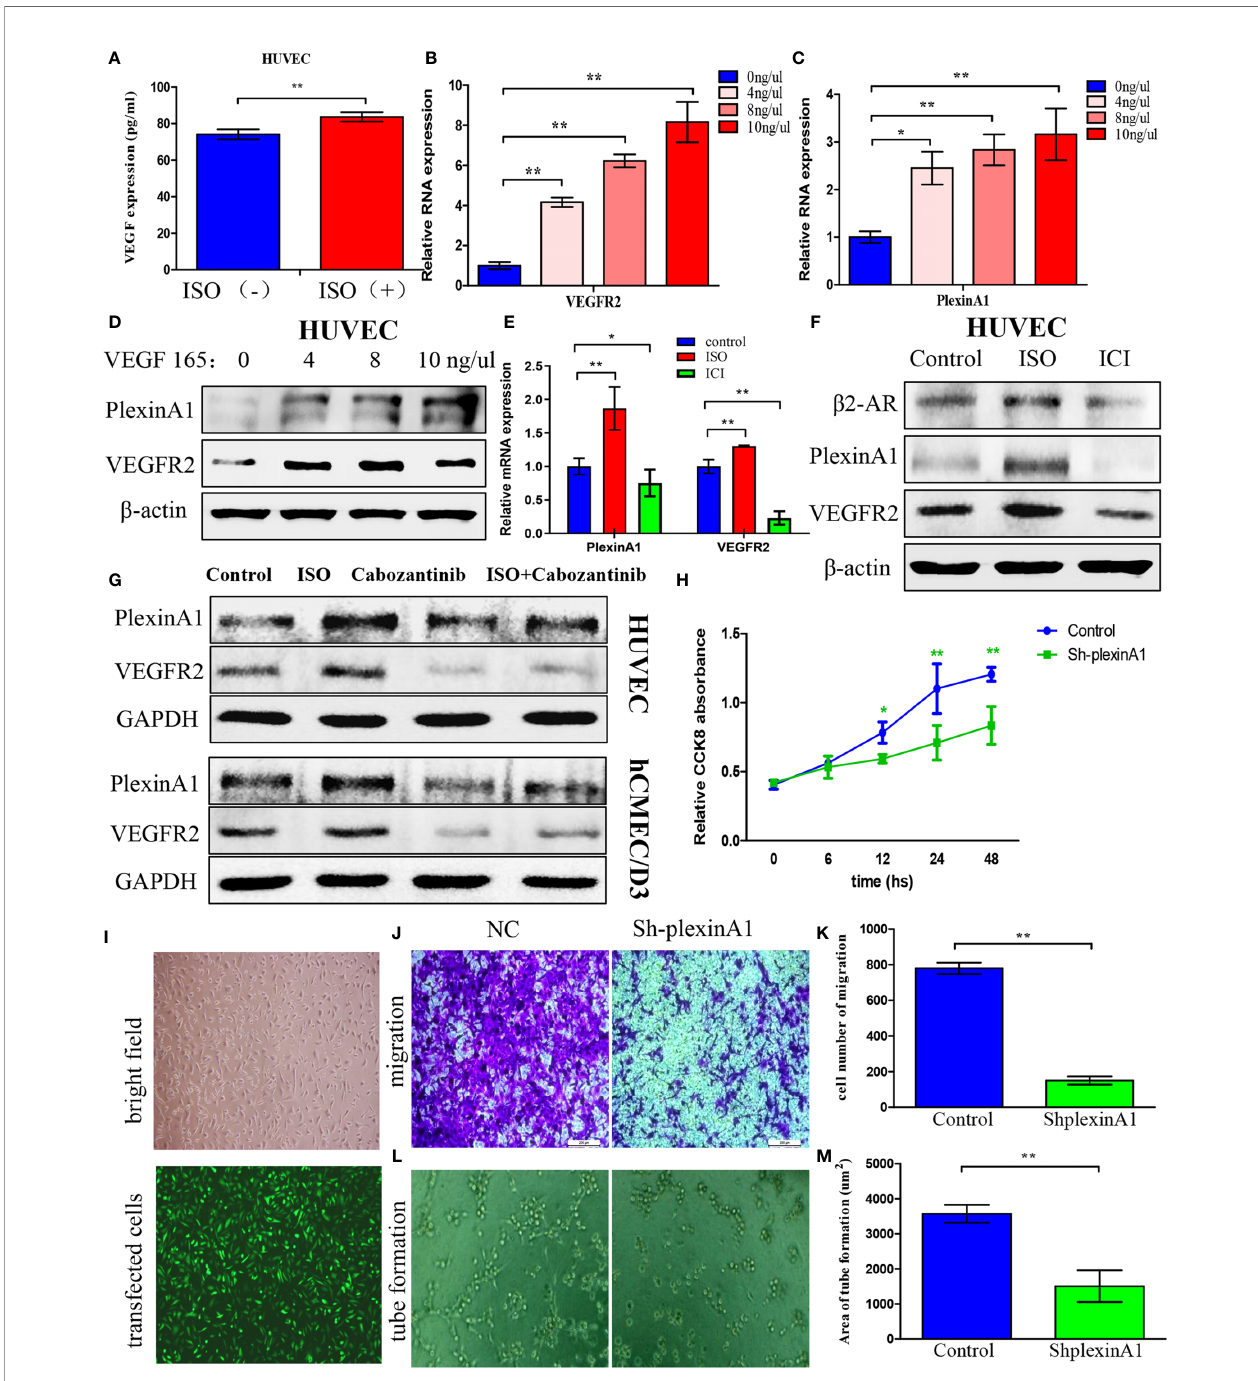
FIGURE 3 | Isoprenaline promotes VEGF autocrine of HUVECs, which can induce plexinA1 and VEGFR2 expression. (A) HUVECs were exposed to 5 m M ISO for 4 h Elisa assay revealed VEGF autocrine of HUVECs. (B – D) HUVECs were treated with 0, 4, 8, 10 ng/ml of VEGF165 for 24h. The relative VEGFR2 (B) and plexinA1 (C) mRNA levels were detected by qRT-PCR, and their protein levels were detected through WB (D) . (E, F) HUVECs were treated with ISO or ICI. The relative mRNA (E) and protein (F) levels of b 2-AR, VEGFR2 and plexinA1 were analyzed. (G) HUVECs and hCMEC/D3 were treated with ISO or Cabozantinib. The protein levels of VEGFR2 and plexinA1 were analyzed by WB. (H – M) HUVECs were classi fi ed as shRNA knockdown (ShplexinA1) or control (NC) group. (H) The proliferative ability of HUVECs were detected by CCK8 assay. (I) The optical microscopic image (up) and the fl uorescence microscopic image (down). Representative photographs of migration (J) and tube formation (L) , and quantitative analysis of migration (K) and tube formation (M) are shown. Data are expressed as mean ± SD (n = 3, *P < 0.05, **P <